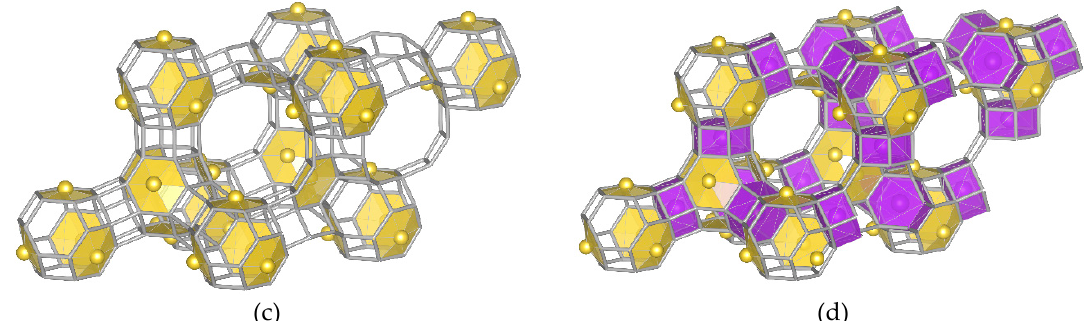
Figure 1. Fragment of the FAU structure (Me 32 Si 160 Al 32 O 384 , Fm-3c space group): ( a ) silicate FAU framework, ( b ) model “A”, ( c ) model “B” and ( d ) model “C” (descriptions of individual models in the text).